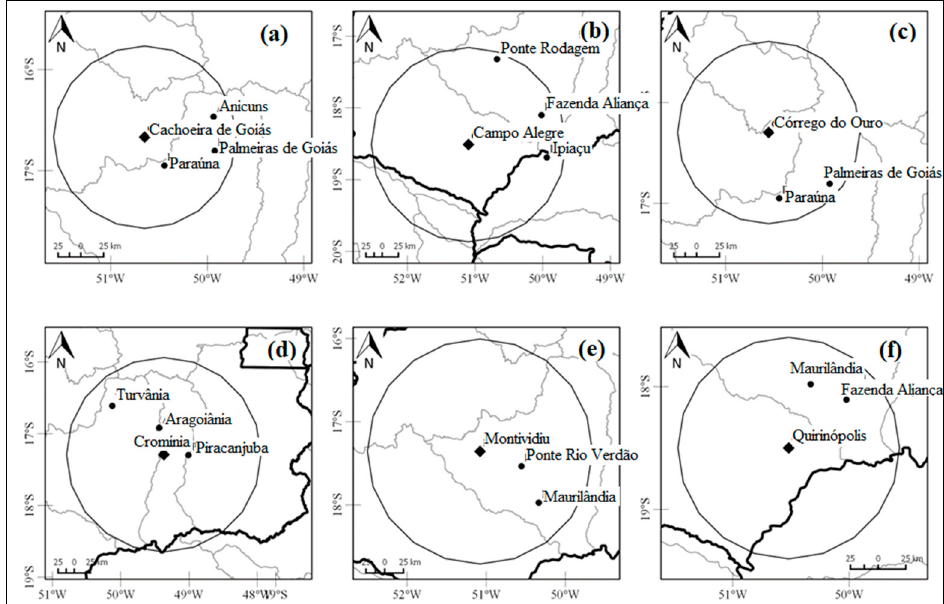
Figure 3. Locations of the target sites and their respective “donor” stations for filling monthly rainfall values with the multiple linear regression model. Test stations: ( a ) Cachoeira de Goiás ( b ) Campo Alegre ( c ) Córrego do Ouro ( d ) Cromínia ( e ) Montividiu, and ( f ) Quirinópolis.